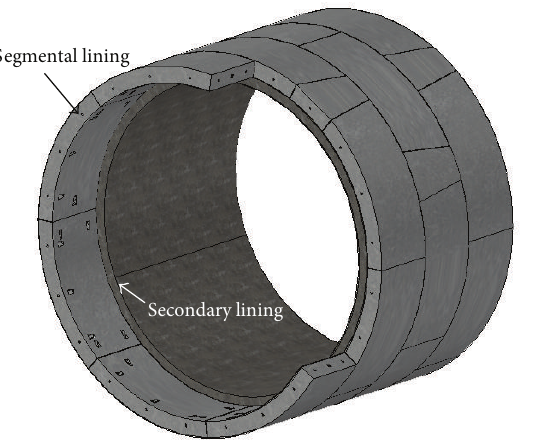
Figure 1: Sketch of shield tunnel with double